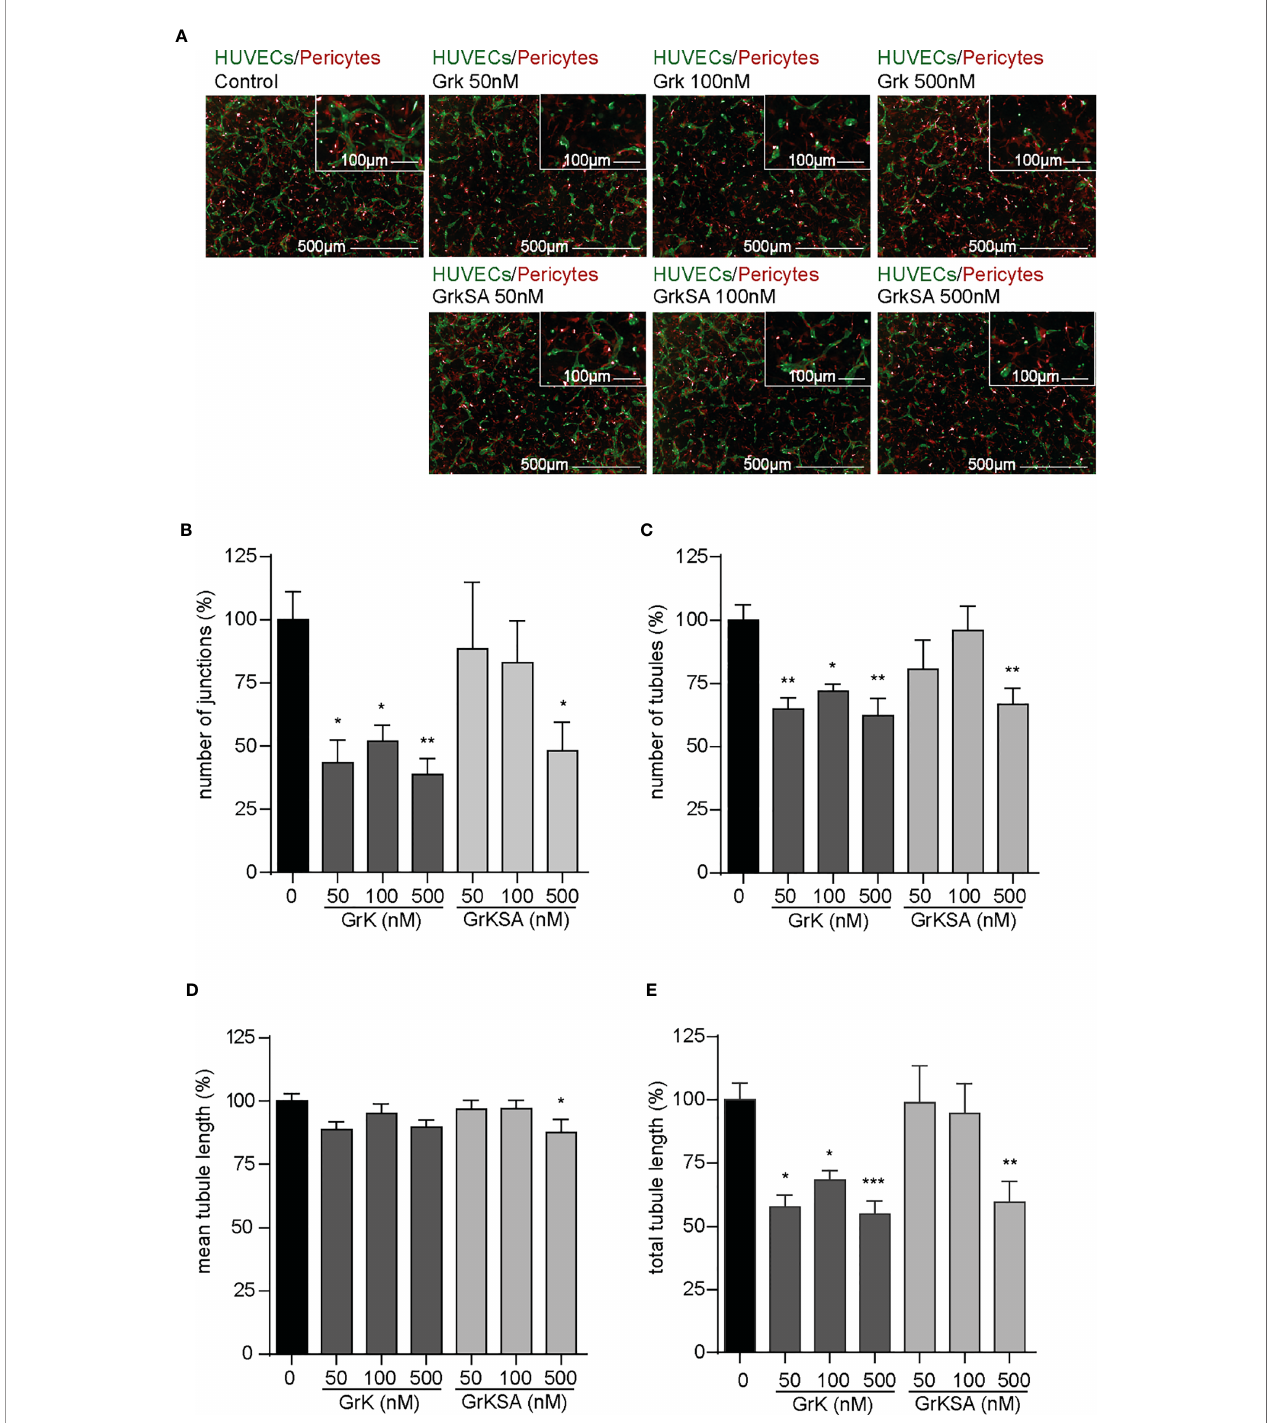
FIGURE 1 | GrK inhibits angiogenesis in vitro . A co-culture of pericytes and endothelial cells in a 3D collagen gel was treated with a concentration series of GrK and GrKSA. (A) Representative fl uorescent microscope images of GFP-labeled HUVECs (green) in co-culture with dsRED-labeled pericytes (red) in a 3D collagen matrix during vascular formation. Shown are the results at day 3 of an untreated control and after stimulation with different concentrations of GrK or GrKSA. Scale bar =500µm. Right corner corresponding to the inset, scale bar=100µm. Angiogenesis was described via (B) number of junctions, (C) number of tubules, (D) mean tubule length and (E) total tubule length. For all parameters, relative values compared to mock concentration (100%) are shown. Results are depicted as mean ± SEM, n ≥ 10. *P < 0.05; **P < 0.01; ***P < 0.001, compared to